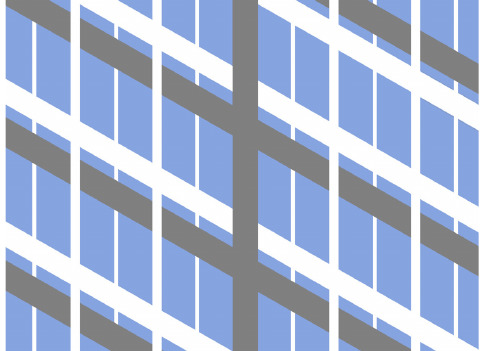
Fig. 1. Arrangement of blue (reflected sky), white and gray figures gives the impression of two interweaving threads – as in a textile cloth. Image inspired by the patterned facade of the Mile High Center building in Denver (arch. I. M. Pei, 1959). A clear declaration of the phenomenal transparency by Rowe and Slutzky. Fig. by